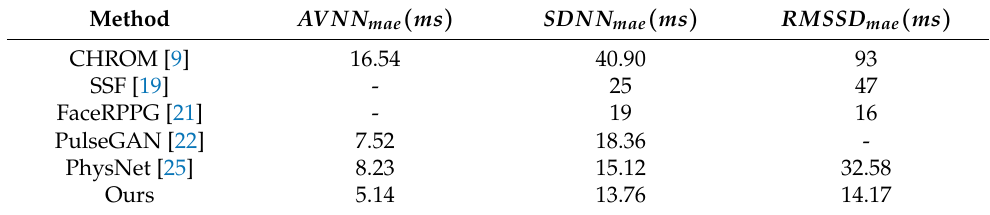
Table 2. The result of time-domain metrics on the UBFC-rPPG dataset.